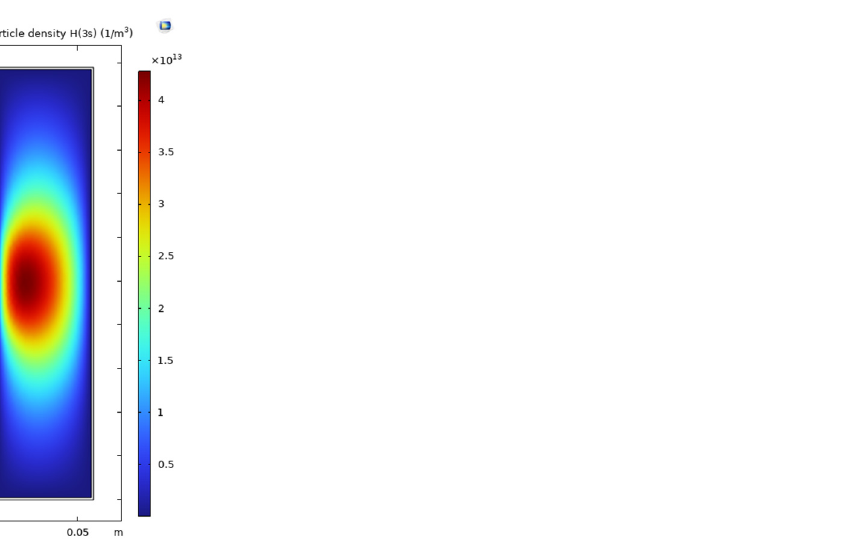
Figure 7. Simulated H(3s) density distribution (with 35% H 2 , at pressure of 5 Pa and power of 165 W).